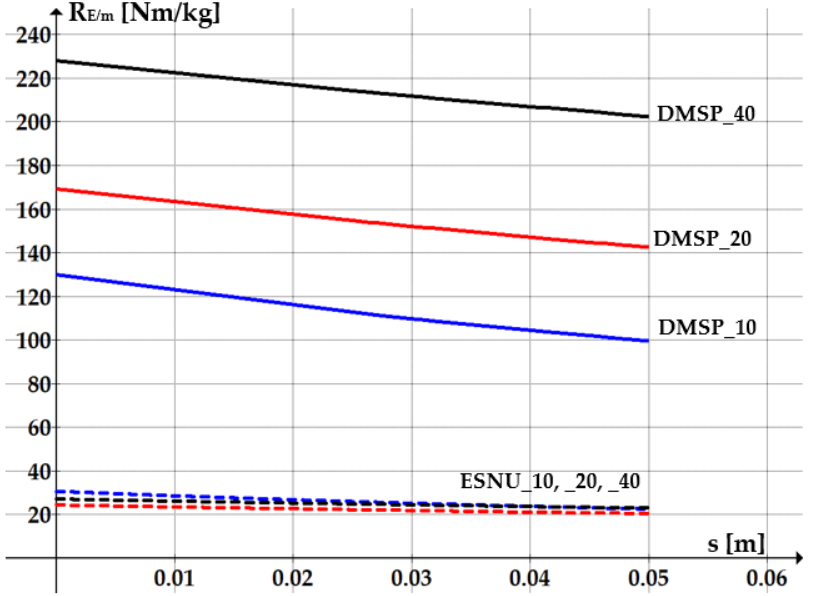
Figure 7. Variation of the energy-to-mass ratios versus strokes of the pneumatic motors.